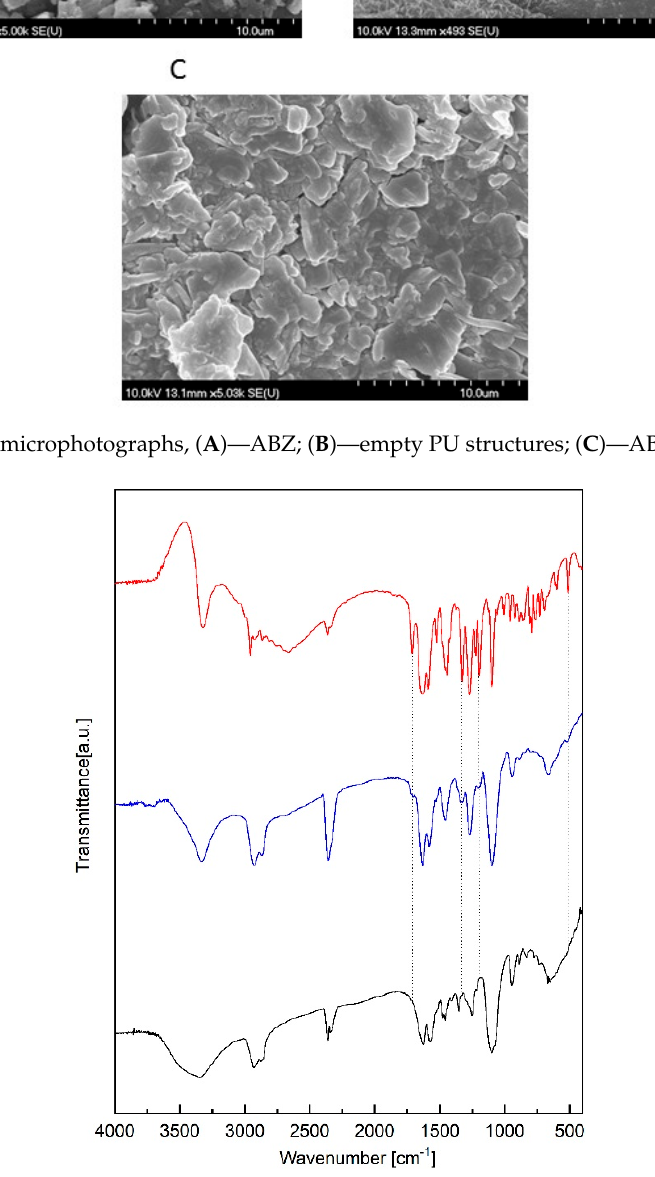
Figure 6. FTIR spectra of ABZ (red), ABZ-PU (blue) and PU (black).